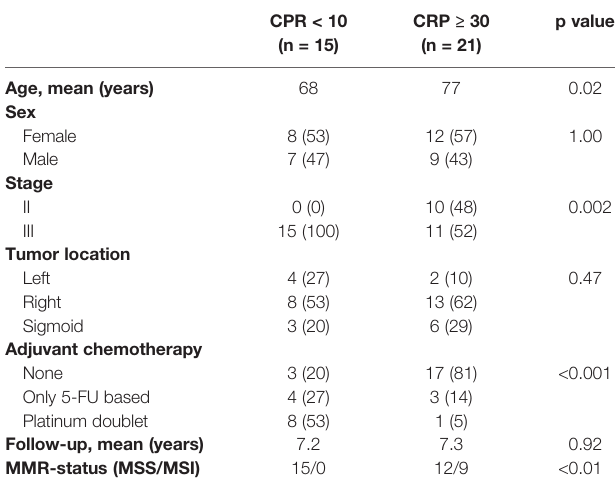
TABLE 1 | Patient and tumor characteristics in CRP high and -low colon cancer